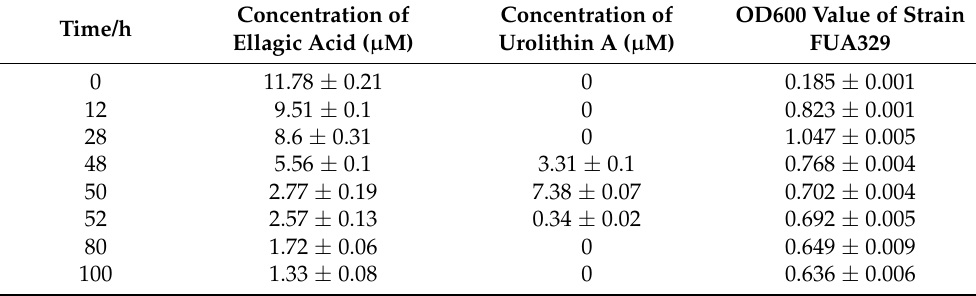
Figure 4. Time course of ellagic acid catabolism and urolithin A accumulating in the fermentation broth of the strain FUA329. Ellagic acid (solid squares), urolithin A (solid circles), and the strain FUA329 growth curve (solid triangles). Table 2. The key time point of the strain FUA329 growth and urolithin A